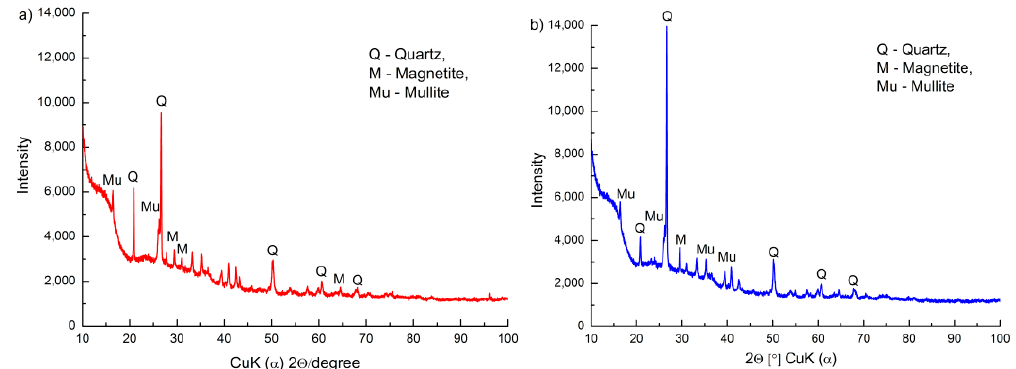
Figure 3. X-ray diffraction (XRD) patterns of ( a ) raw FA and ( b ) H 2 O 2 -treated FA.